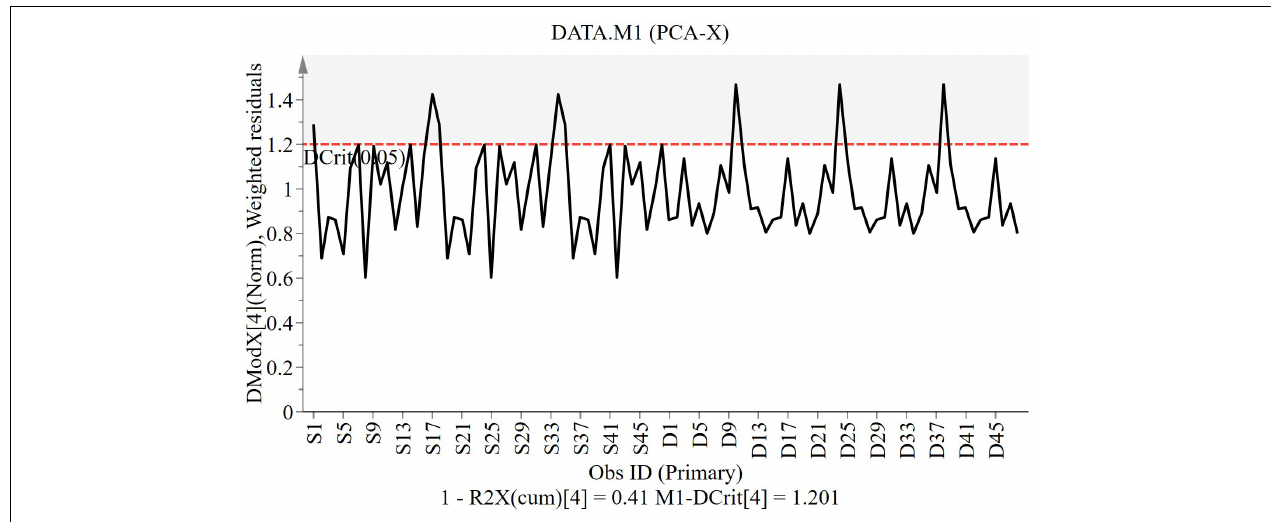
FIGURE 2 | DModX line of the study groups. PCA, principal component